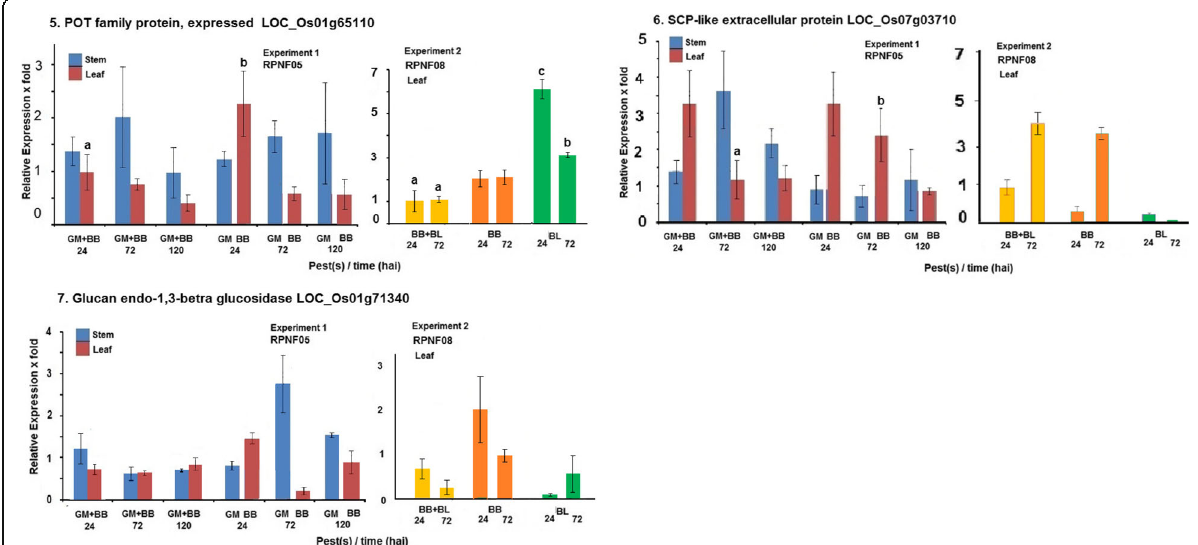
Fig. 2 Relative levels of expression of the selected three defense related genes in rice line RPNF05 following challenge by BB and/or GM